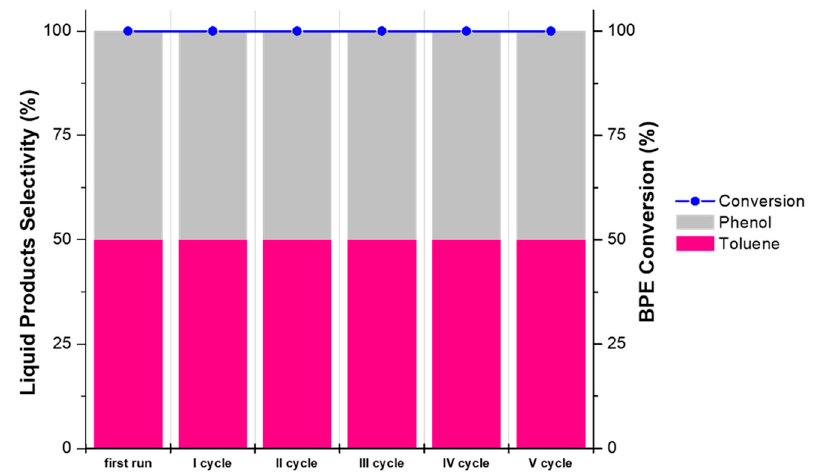
Figure 9. Recycling test of the Pd/Fe 3 O 4 [wnf] catalyst in the CTH of BPE at 240 °C (reaction conditions: 0.125 g of catalyst; 40 mL of 0.1 M BPE solution; time, 360 min; N 2 pressure, 10 bar; stirring, 500 rpm).